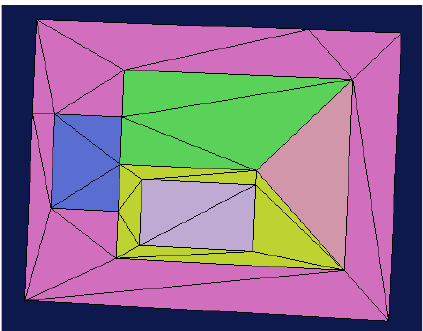
Fig. 2. Roof and terrain triangles are explicit parts of the model, as are vertical lines connecting positions at different heights of a point. Slanted lines at walls are not part of the model, but are added by the rendering software.